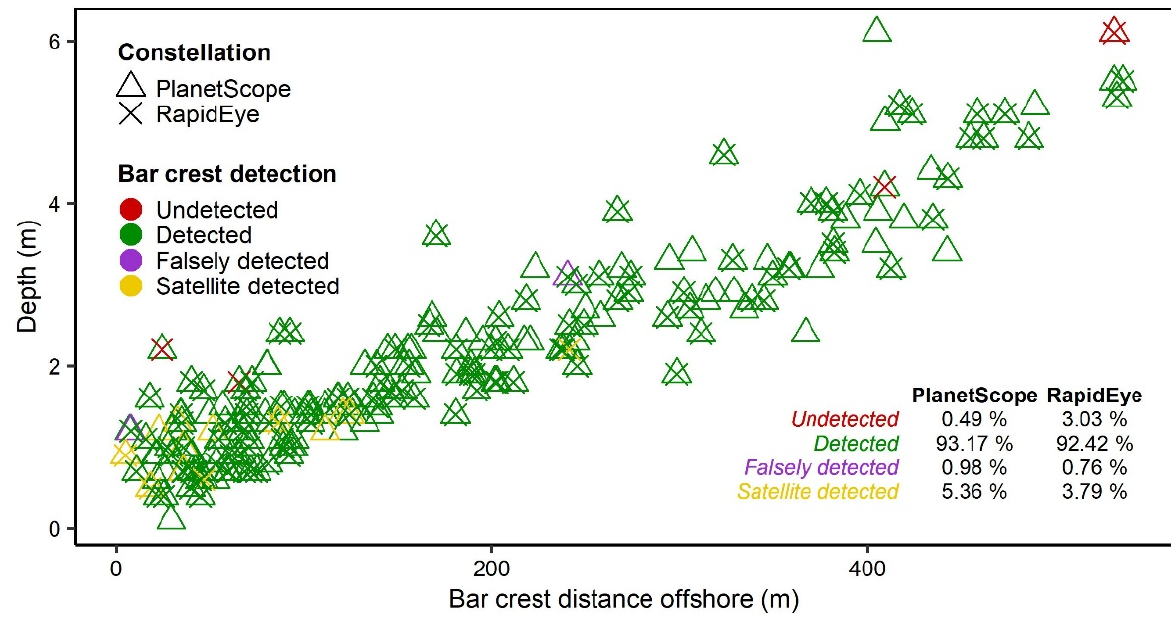
Figure 11. The ability of the algorithm to detect sandbars in PlanetScope and RapidEye images compared to measured data: undetected—sandbars visible in bathymetric cross-shore profile and undetected by the algorithm; detected—sandbars visible in bathymetric cross-shore profile and detected by the algorithm; falsely detected—non-existing sandbars, extracted by the algorithm; satellite detected—sandbars not-visible in cross-shore profiles, but identified by the algorithm.